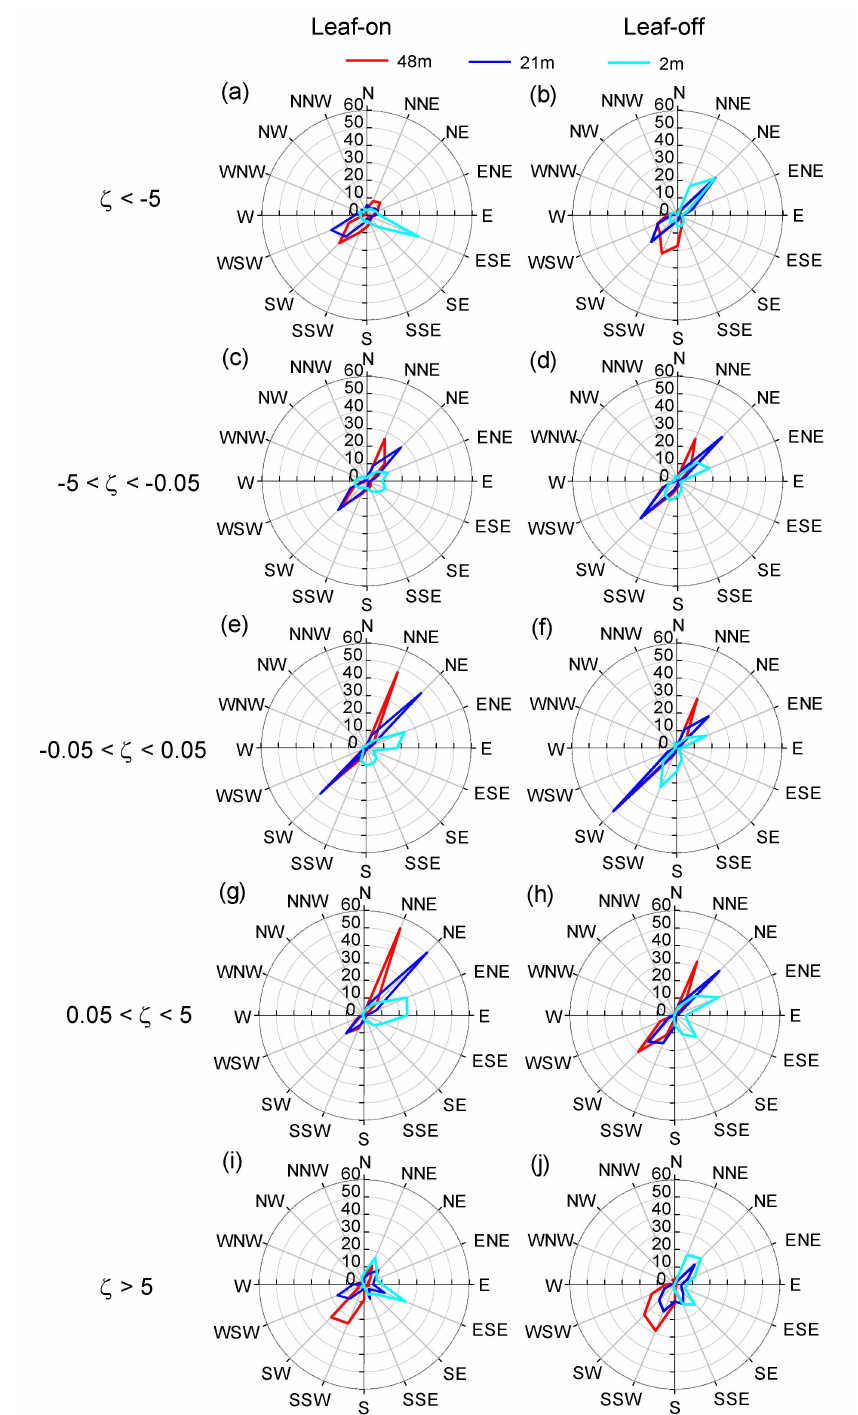
Figure 10. Relative frequency distributions of wind direction at the 48 m, 21 m and 2 m for five stability regimes during the leaf-on and leaf-off seasons of 2012. ( a ) and ( b ) are for ζ< −5 in leaf-on and leaf-off seasons, correspondingly. ( c ) and ( d ) are for −5 < ζ < −0.05 in leaf-on and leaf-off seasons, respectively. ( e ) and ( f ) are for −0.05 < ζ < 0.05 in leaf-on and leaf-off seasons, respectively. ( g ) and ( h ) are for 0.05 < ζ < 5 in leaf-on and leaf-off seasons, respectively. ( i ) and ( j ) are for ζ > 5 in leaf-on and leaf-off seasons,